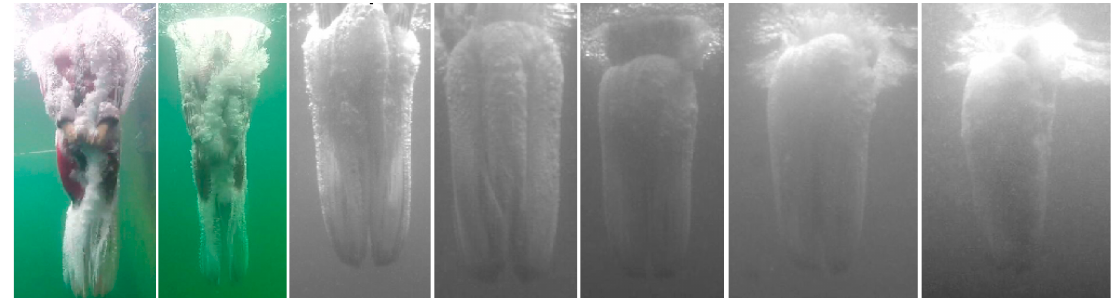
Figure 5. Pictures of air cavities taken at the moment of collapse for dives from several initial heights: 1.7, 3, 5, 10, 14, 20 and 27 m (from left to